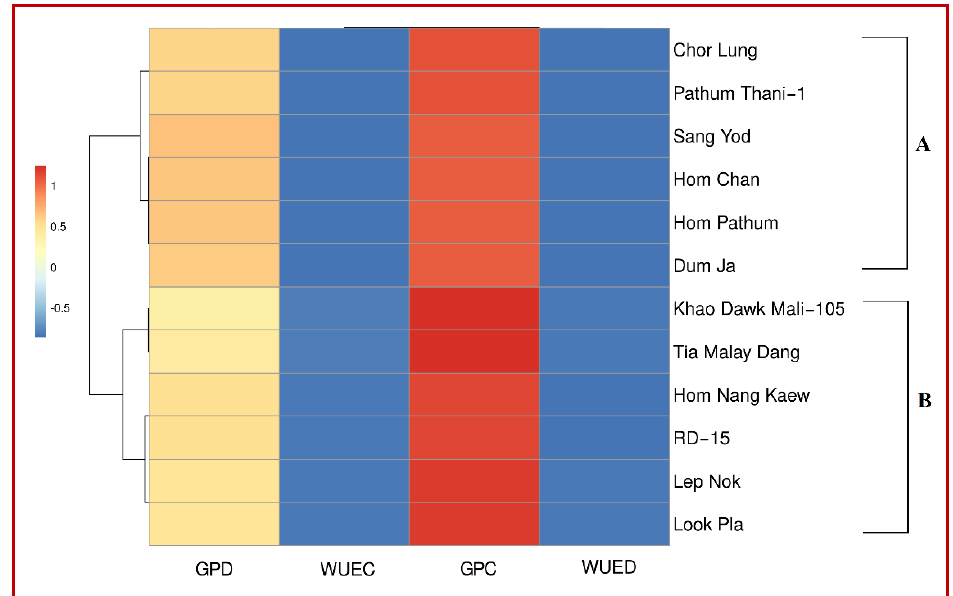
Figure 6. Heatmap of grain productivity under drought stress (GPD), water use efficiency under control (WUEC), grain productivity under control (GPC) and water use efficiency under drought stress (WUED) among twelve lowland rice cultivars. Cultivars are classified into two groups (A and B), and each group is comprised of similarly acting cultivars. Higher association is indicated by dark colors, whereas light colors indicate lower association among cultivars and attributes.